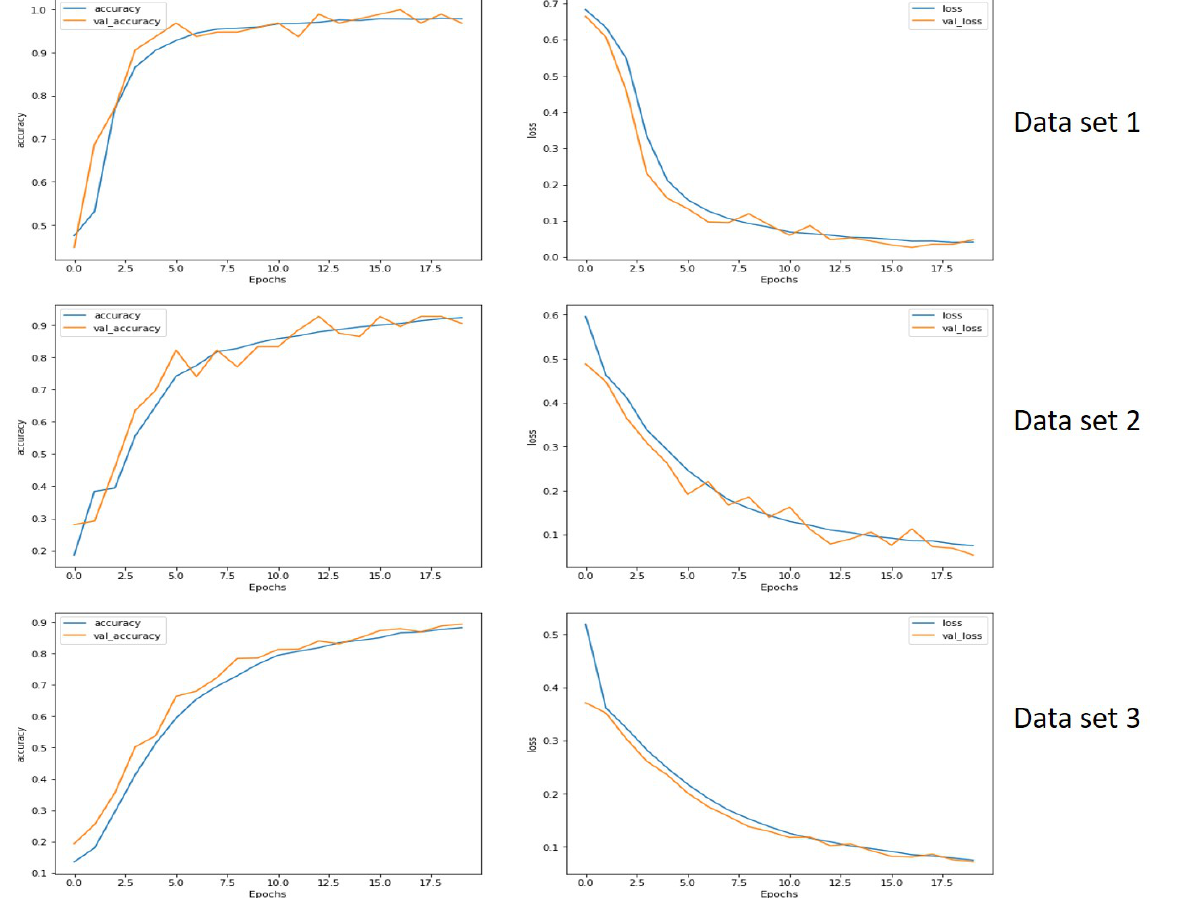
Figure 7. Loss and accuracy functions from the